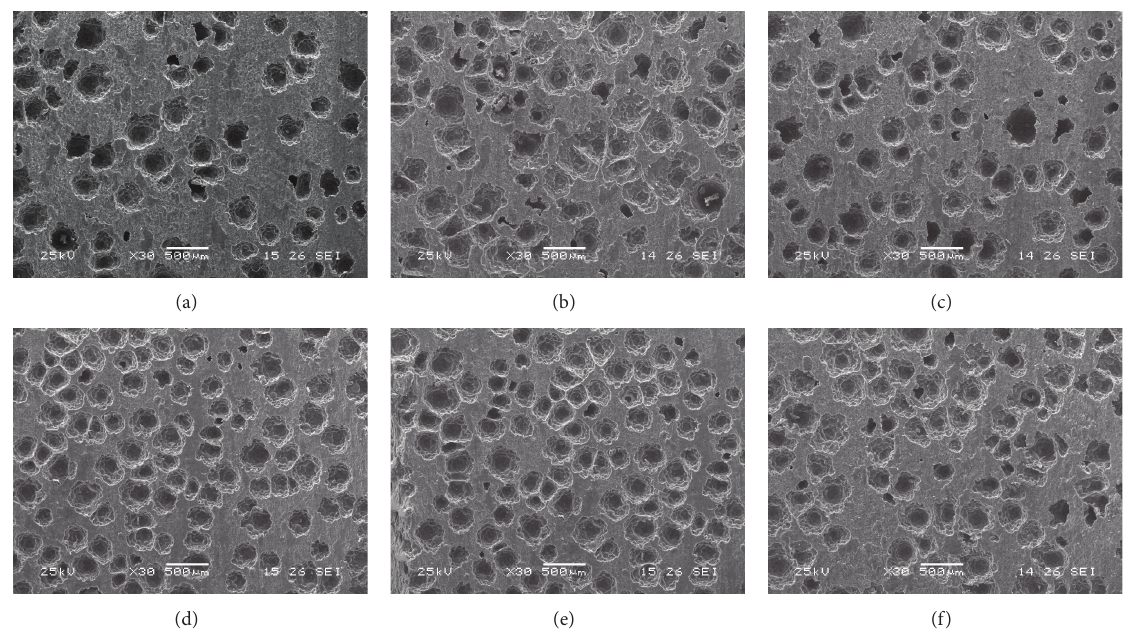
Figure 2: Electron microscopy of the metal-bone cement interfaces: (a) and (d) before immersion and 4 weeks after immersion in G 0 , respectively; (b) and (e) before immersion and 4 weeks after immersion in G 3 , respectively; and (c) and (f) before immersion and 4 weeks after immersion in G 5 , respectively.